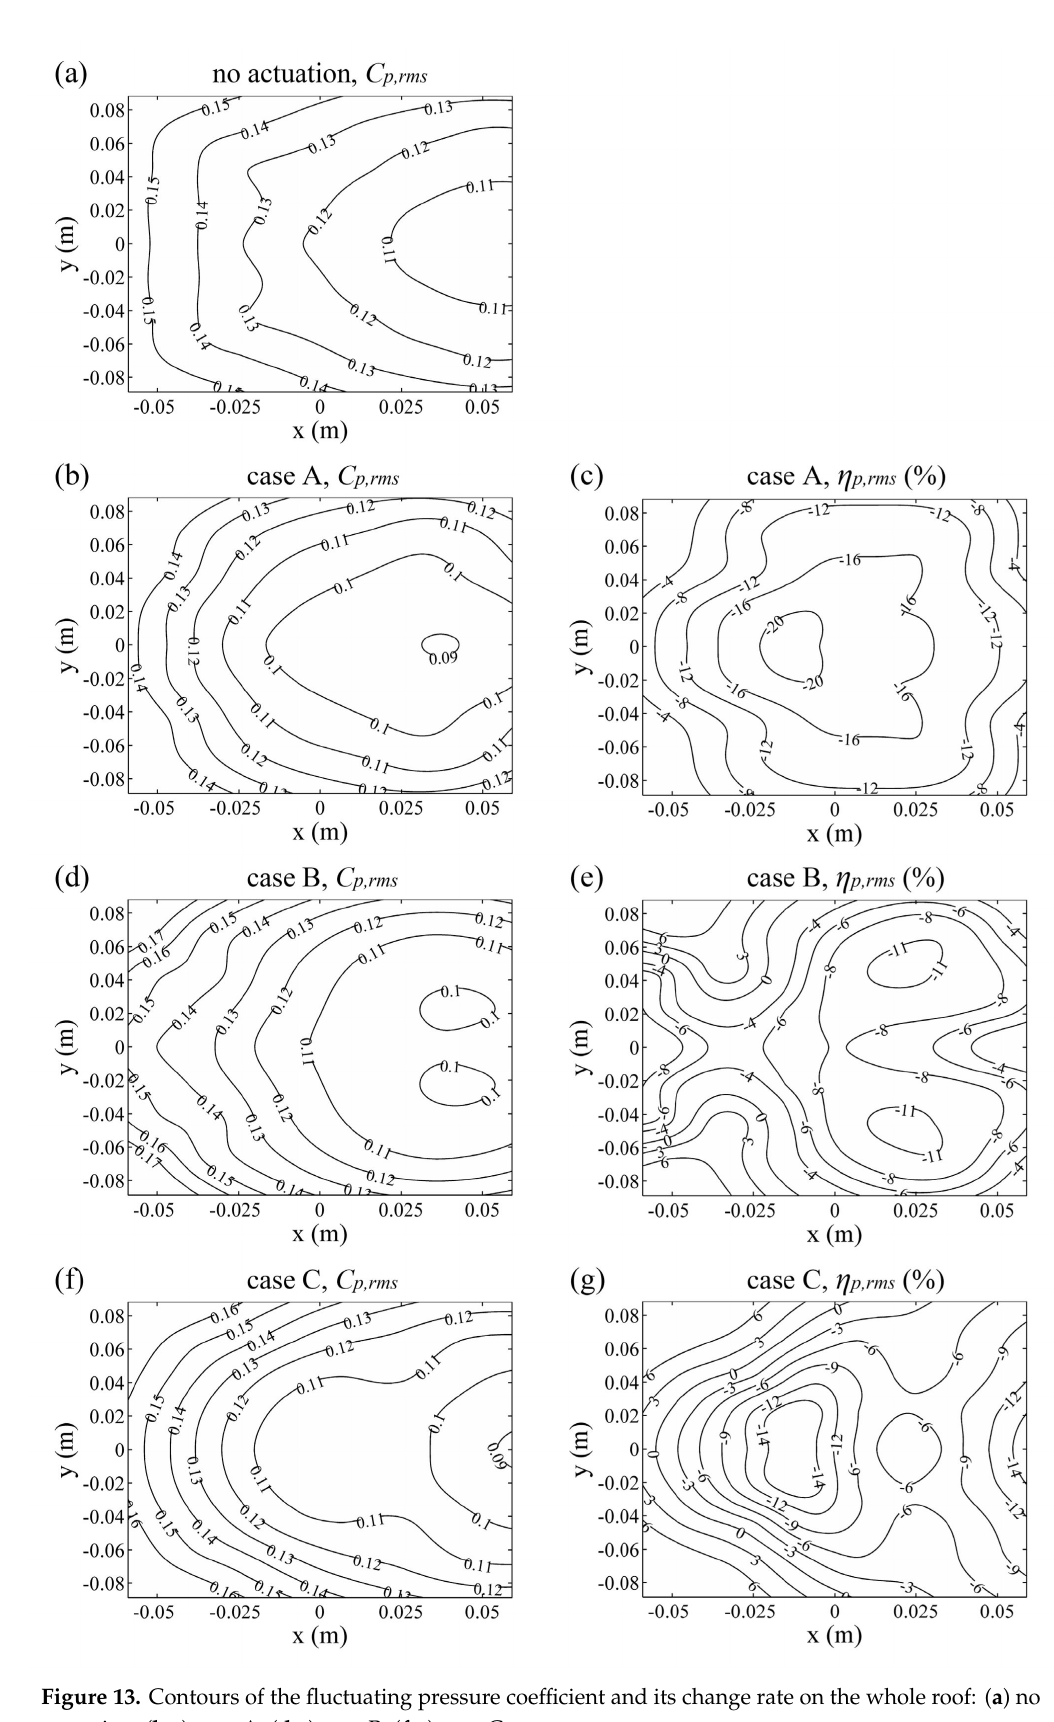
Figure 13. Contours of the fluctuating pressure coe ffi cient and its change rate on the whole roof: ( a ) no actuation; ( b , c ) case A; ( d , e ) case B; ( f , g ) case